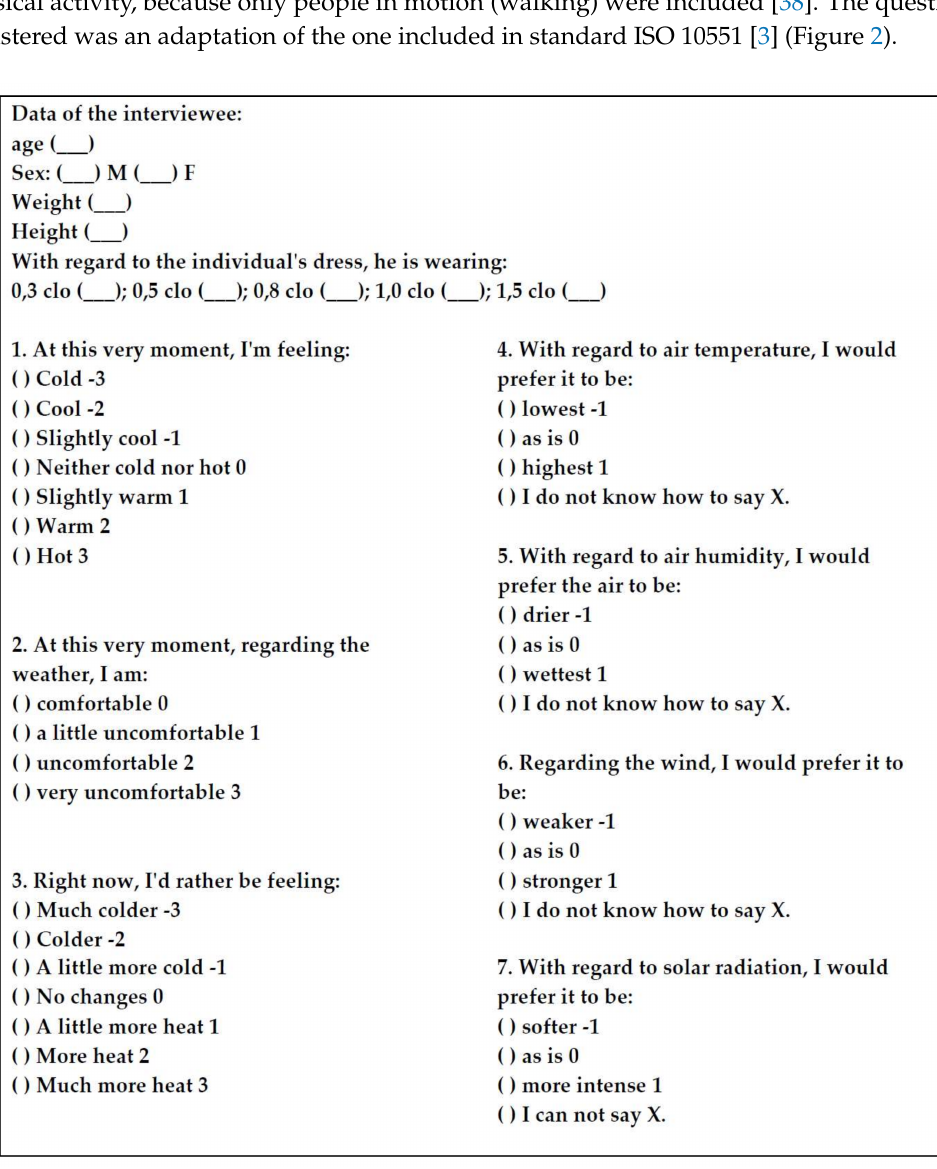
Figure 2. Questionnaire